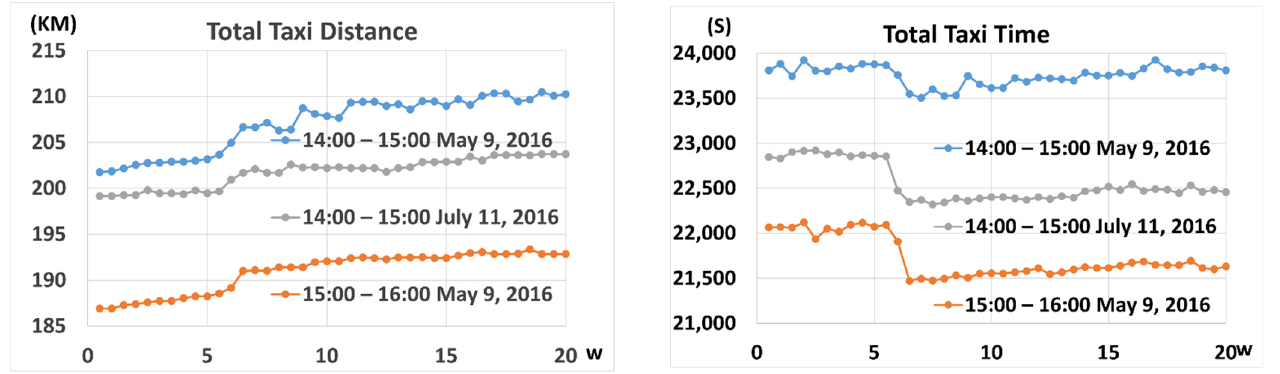
Figure 15. MILP weight parameter analysis result.